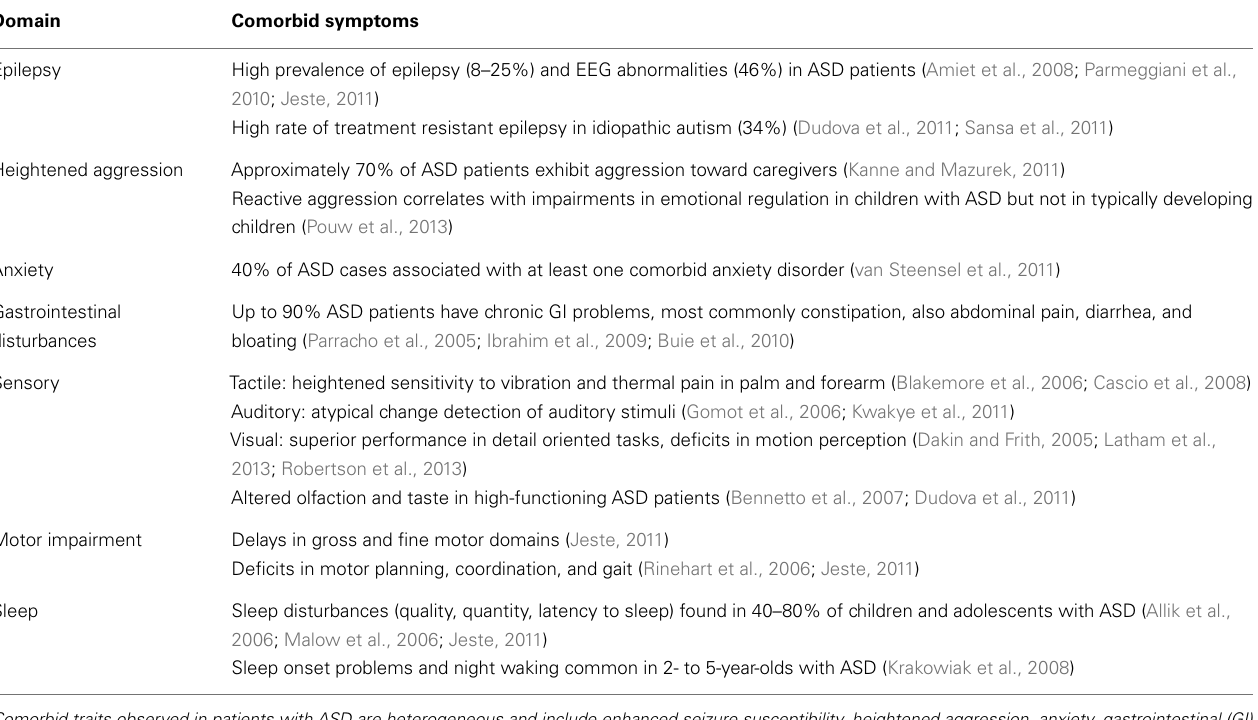
Table 1 | Clinical comorbidities commonly associated